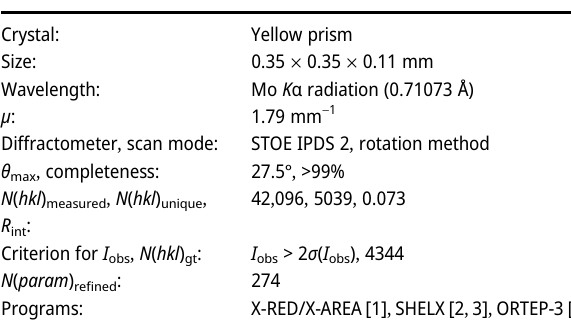
Table  : Data collection and